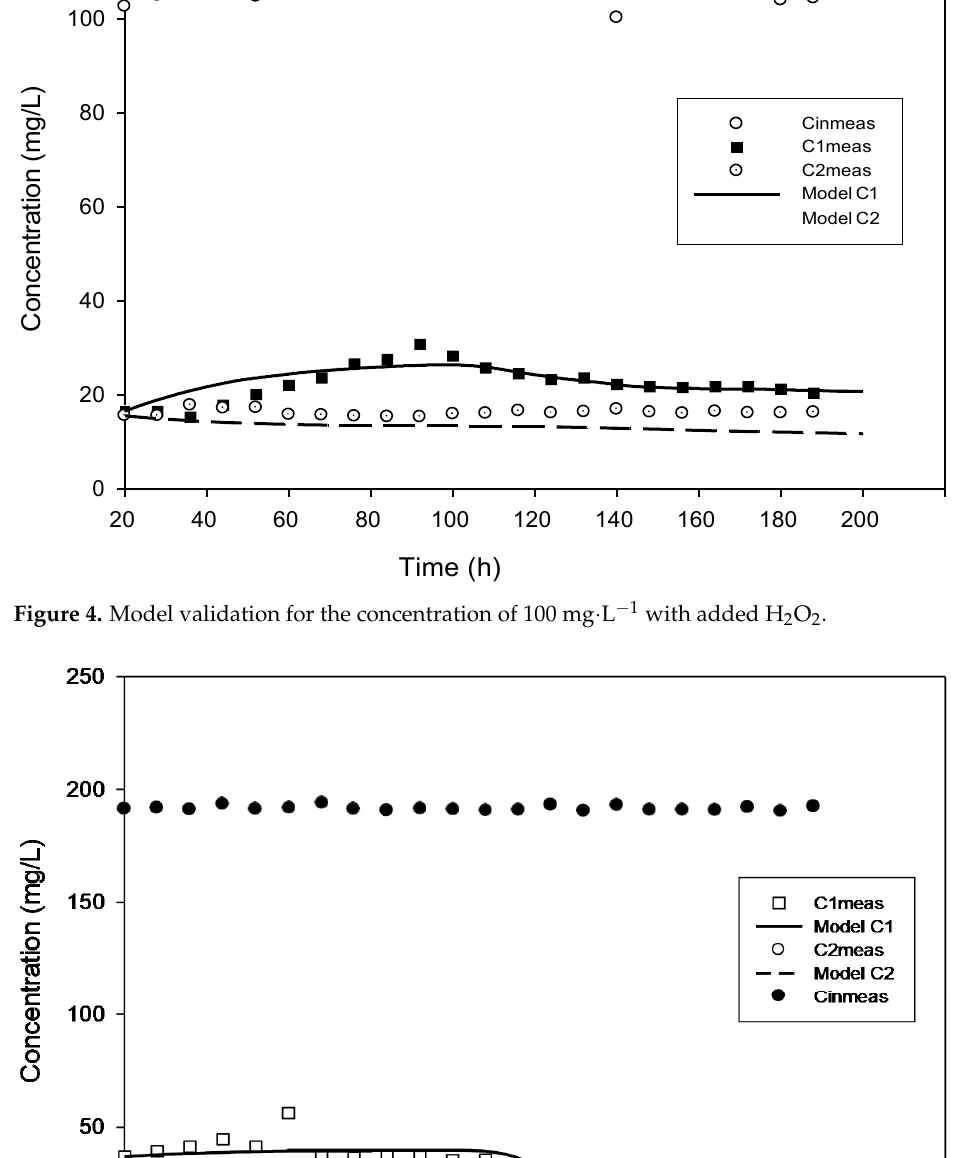
Figure 3. Model validation for the concentration of 50 mg·L − 1 with added H 2 O 2.